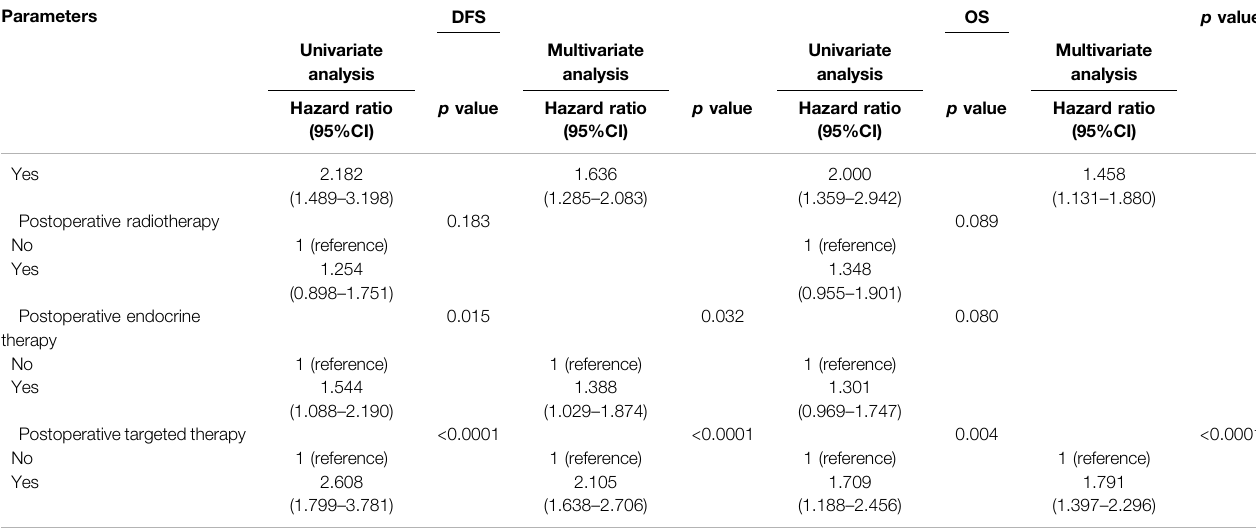
TABLE 3 | ( Continued ) Survival analyses based on univariate and multivariate Cox regression methods for predicting breast cancer patient DFS and